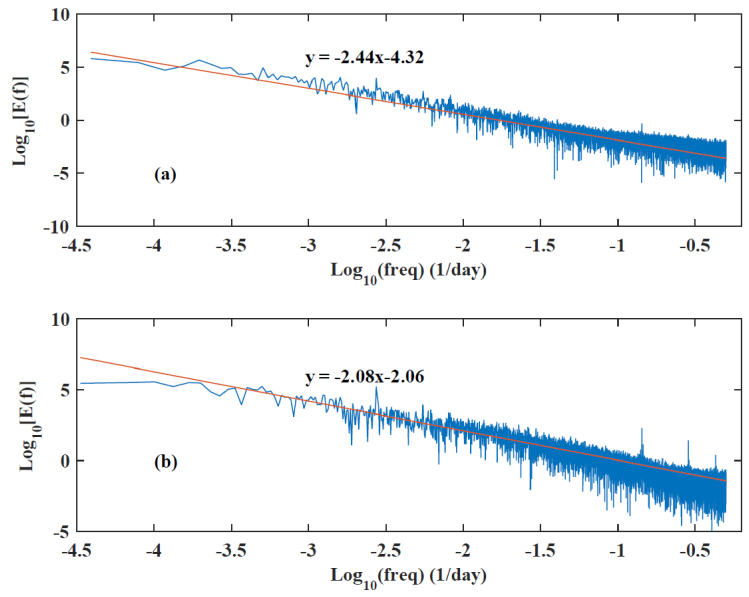
Figure 3. Power spectra of (a) Well 1 and (b) Well 2 groundwater